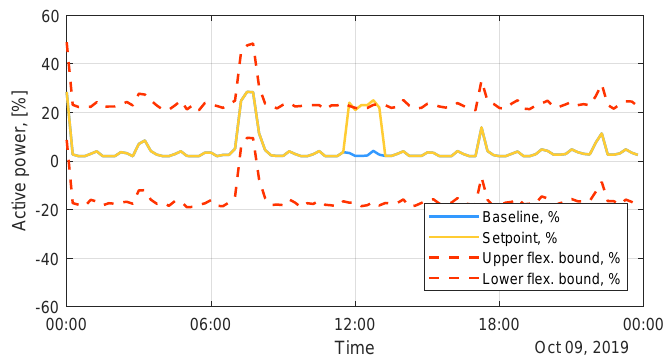
Figure 19. Control action. HEMS connected to node 88.